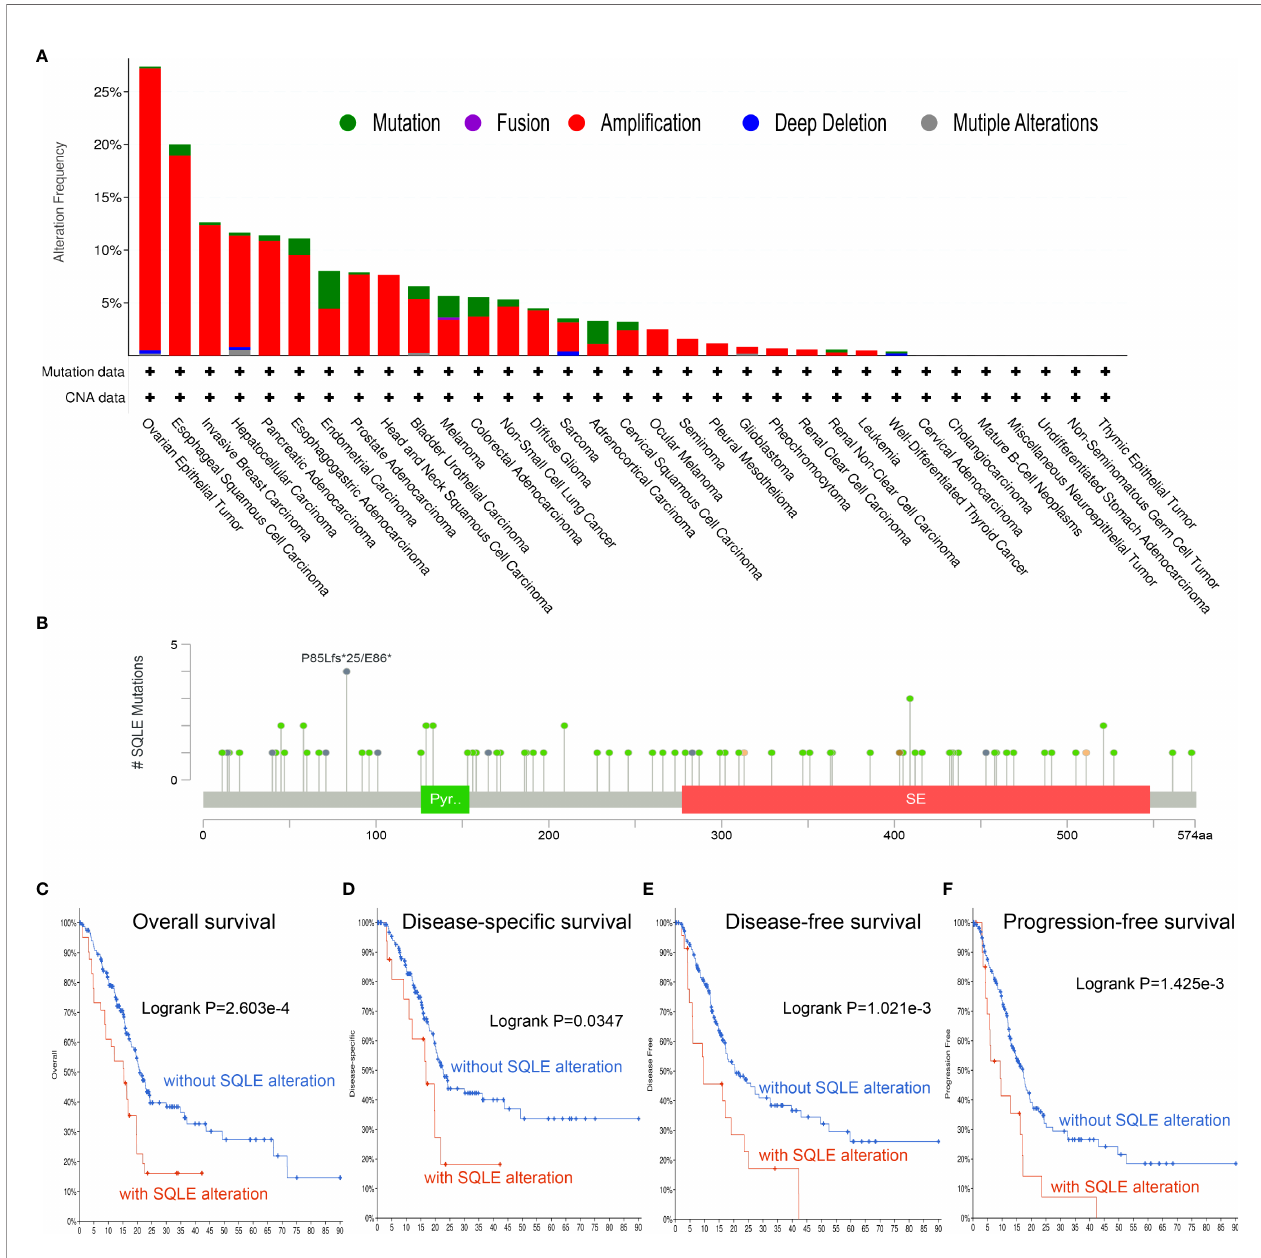
FIGURE 3 | Mutation characteristics of SQLE determined using the cBioPortal database. (A) The alteration frequency with mutational types of SQLE. (B) The mutational sites of SQLE. (C – F) The correlation between SQLE and OS (C) , DSS (D) , DFS (E) , and PFS (F) in